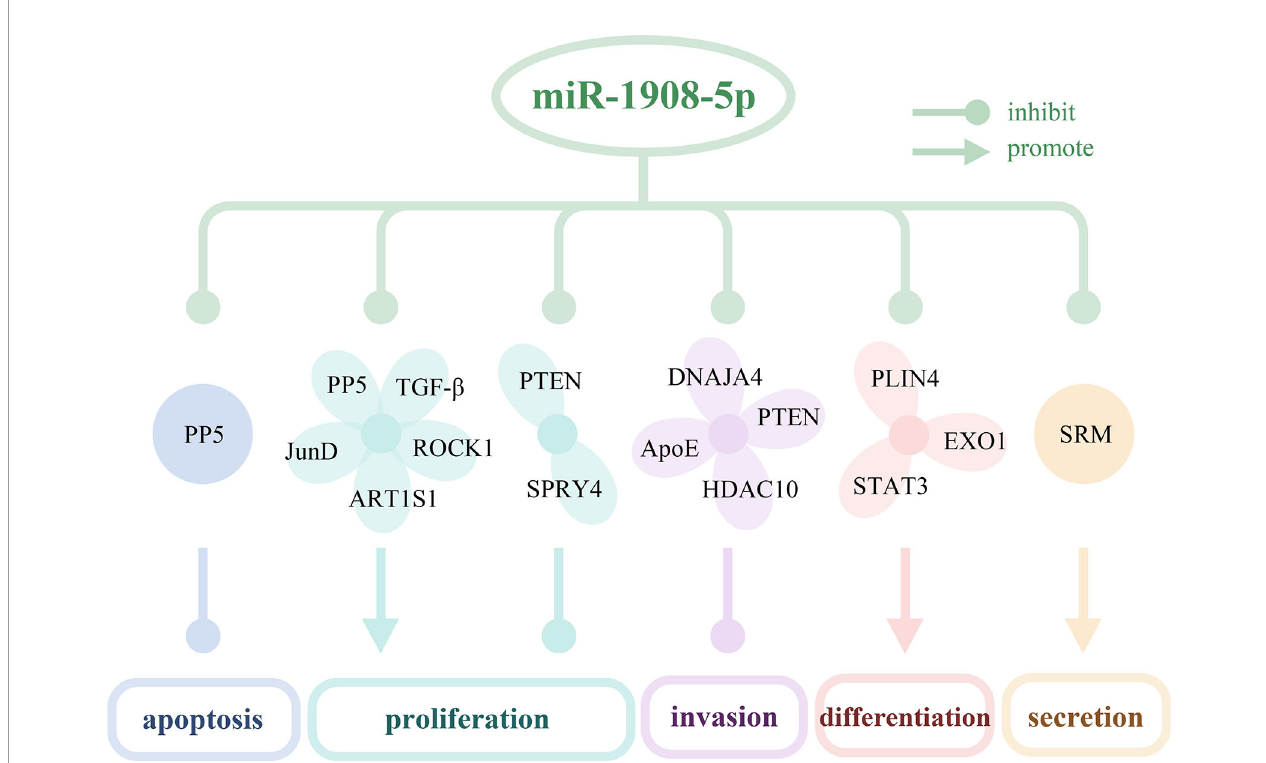
FIGURE 1 | The targeted genes of miR-1908-5p and their effects on cell behaviors. miR-1908-5p regulates cell apoptosis, proliferation, invasion, differentiation, secretion of exosomes by targeting 16